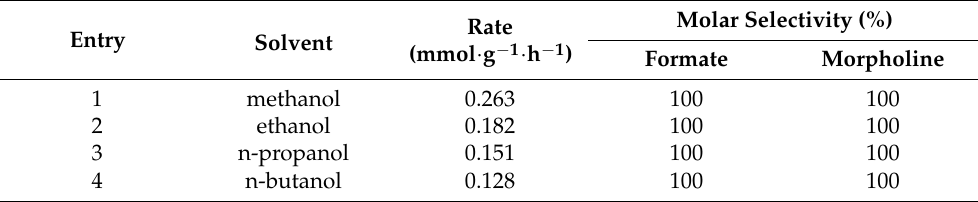
Table 3. Alcoholysis rate of NFM and product selectivities in different alcohol solvents.